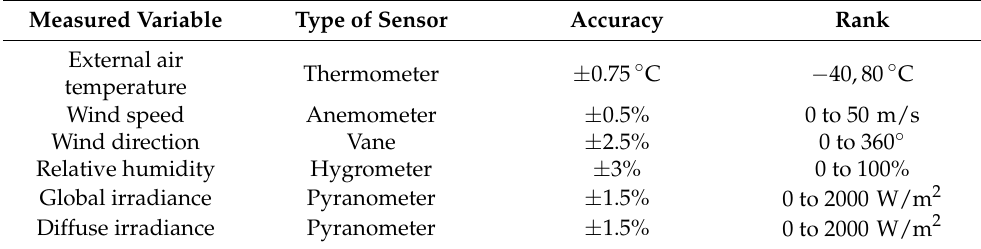
Table 4. Description of the sensors installed at the weather station on the Cell 3 roof. Measured Variable Type of Sensor Accuracy Rank External air Thermometer ± 0.75 ◦ C − 40,80 ◦ C temperature Wind speed Anemometer ± 0.5% 0 to 50 m/s Wind direction Vane ± 2.5% 0 to 360 ◦ Relative humidity Hygrometer Global irradiance